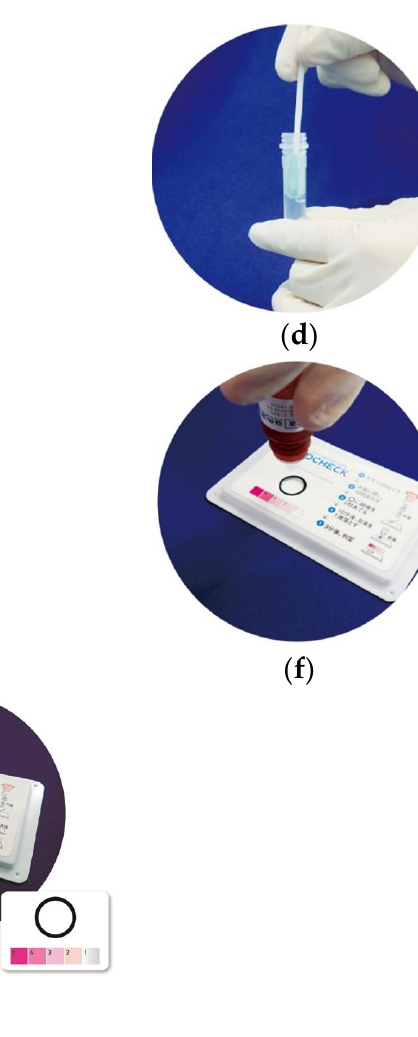
Figure 1. Procedure for using a novel TLP-AA kit, ADCHECK. ( a ) The mechanism of ADCHECK to detect TLP activity. ( b ) Components of the ADCHECK kit. The size of the test plate is 55 mm in length and 85 mm in width. This kit also includes Liquid A for extraction TLP, Liquid B for color reaction, and a swab for collecting the sample. ( c ) Collecting a sample (tongue coating) with a swab. ( d ) Extraction of TLP from samples. The swab containing the sample was stirred well in the tube containing Liquid A. ( e ) The sample was applied to the test plate. The samples were put onto a test-plate disk for 5 s and allowed to react at room temperature for 10 min. ( f ) One drop of 4-dimethylamino cinnamaldehyde colorant (Liquid B) was dropped onto the test-plate disk. ( g ) Color reaction to pink to the released β-naphthylamide. Three minutes after the application of Liquid B, the intensity of the color of the plate disk was visually evaluated using color chart.